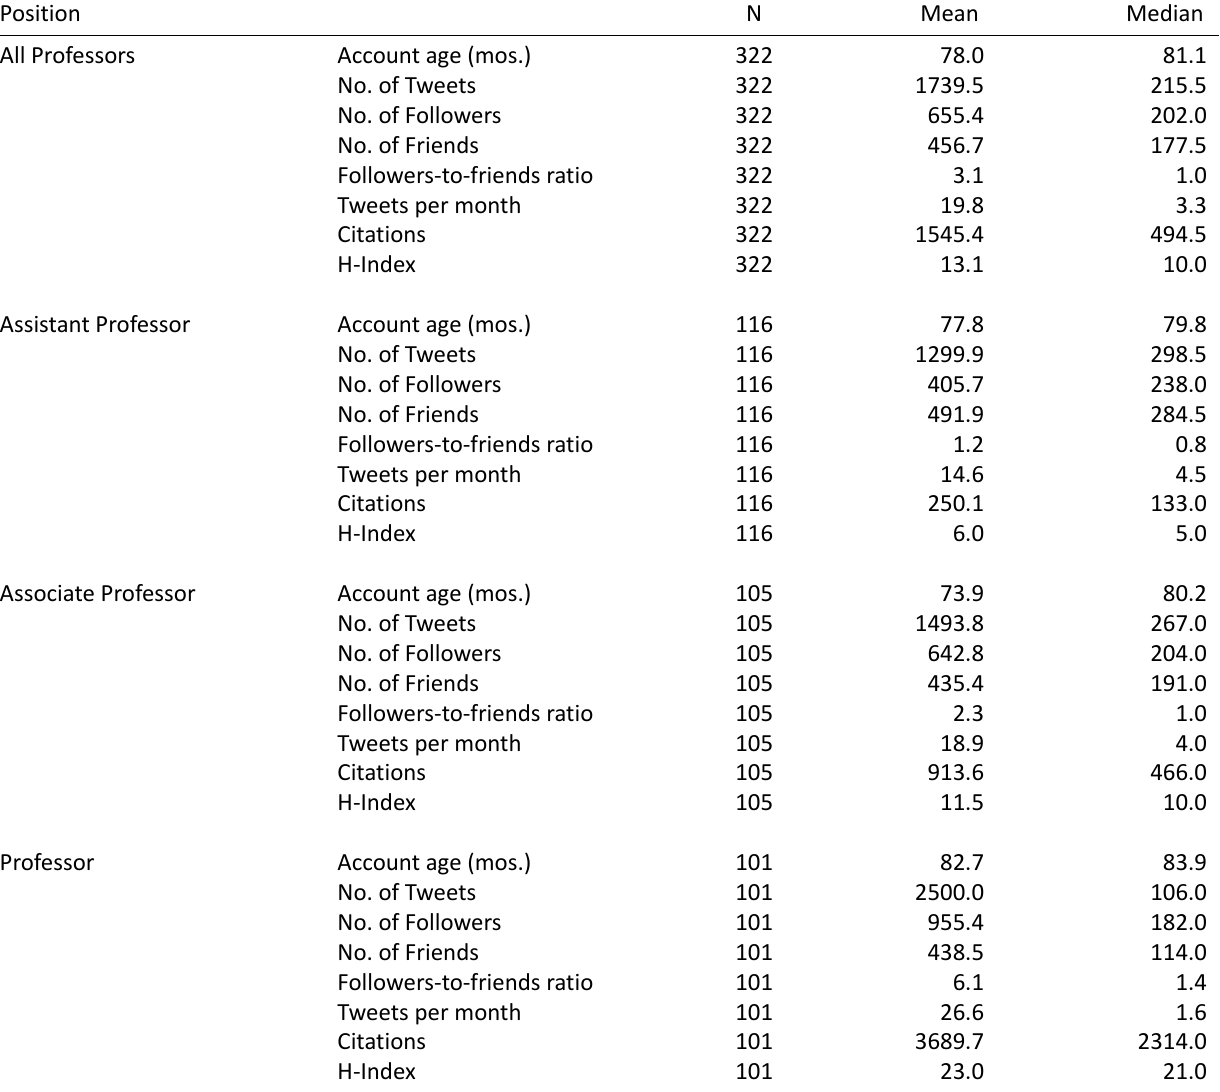
Table 1. Descriptive statistics by academic rank.